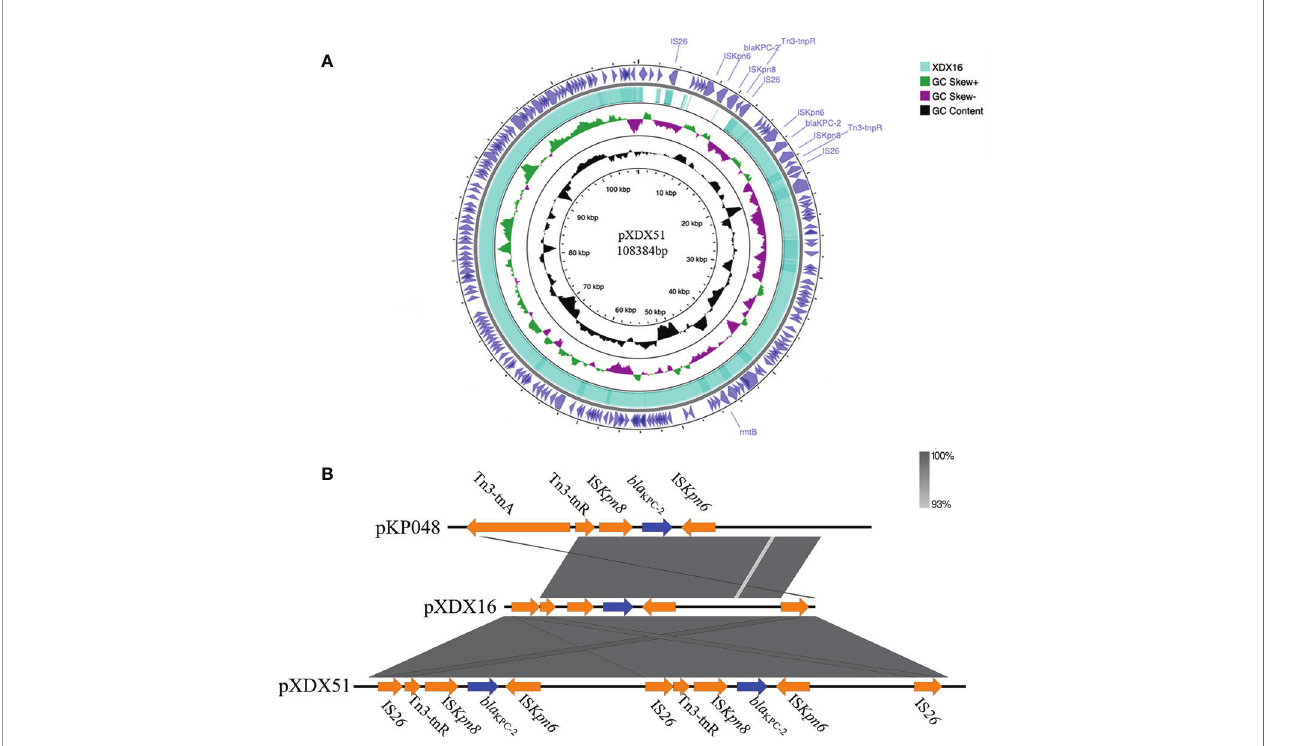
FIGURE 2 | Characteristics of the bla KPC-2 -bearing IncFII plasmid and the genetic environment of bla KPC-2 . (A) Comparison of the IncFII plasmids in XDX51 and XDX16. There were double copies of bla KPC-2 in XDX51 compared to XDX16. (B) The bla KPC-2 environment in our study was compared with that in pKP048. The gene environment of bla KPC-2 in our study was IS 26 -Tn3-IS Kpn8 - bla KPC-2 -IS Kpn6 -hypothetical protein-IS 26 . Blue arrows indicate resistance genes, and orange arrows indicate insertion sequences. The right inverted repeat (IRR) of IS 26 was 5 ’ -ggcactgttgcaaa-3 ’ , the left inverted repeat (IRL) of IS 26 was 5 ’ -tttgcaacagtgcc-3 ’ ; the IRR of IS Kpn8 was 5 ’ -atgtcaagacccggctggttat-3 ’ ; and the IRL of IS Kpn8 was 5 ’ -atcccacgagtccagac-3 ’